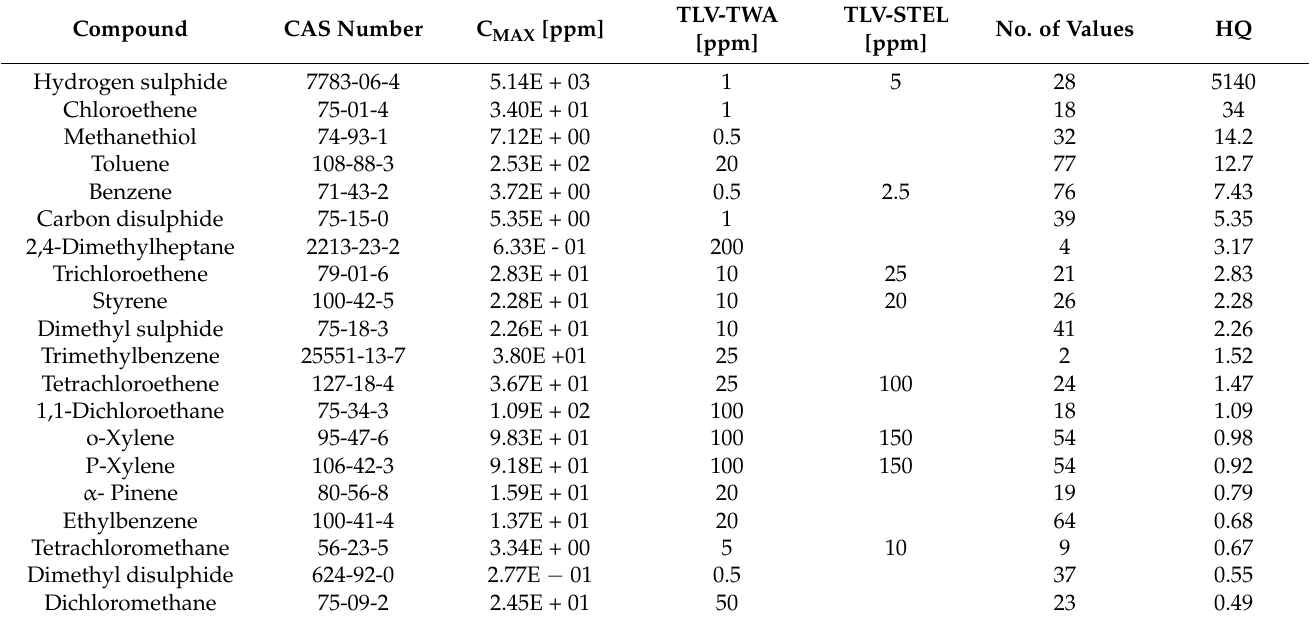
Table 1. Maximum concentration, number of values observed in the literature, TLV and HQ values relevant to the most critical compounds found in